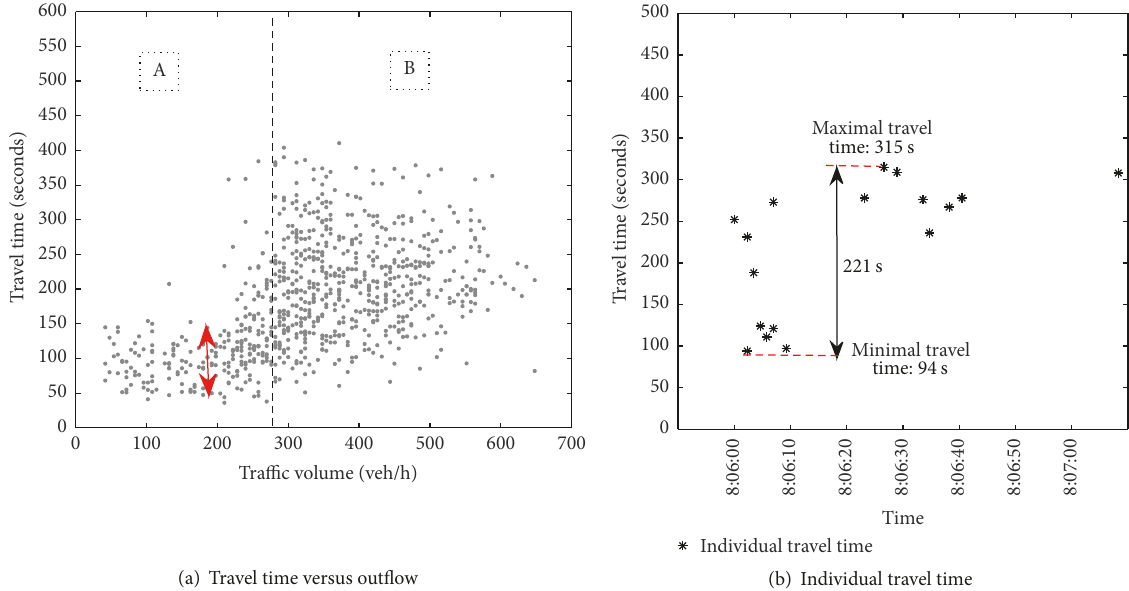
Figure 1: Variability of travel times from empirical data collected on an urban arterial road “Renmin Road” on 20 April 2015 (flow and travel time are both measured in 5 min aggregation; the outliers in travel time have been filtered out) in Changsha City,